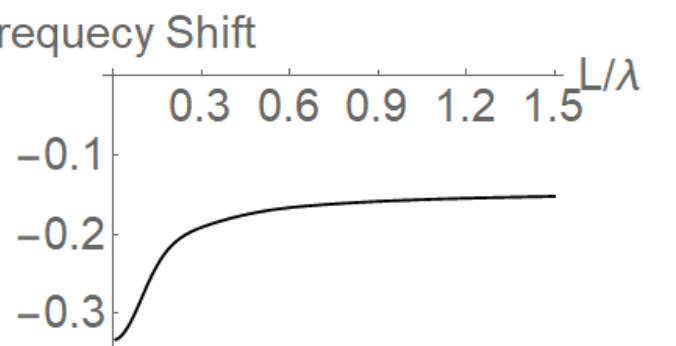
Figure 1. We plot the transmission coefficient as function of the normalized frequency from a typical cloud of uniform number density ( L = 0.25) (the Lorentz shift in the present units is 1/3). λ